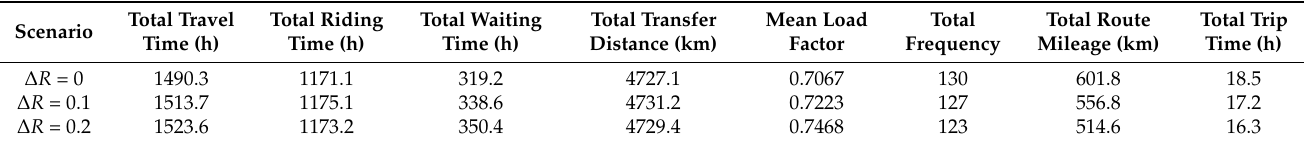
Table 8. Load factor effect on the proposed model performance.